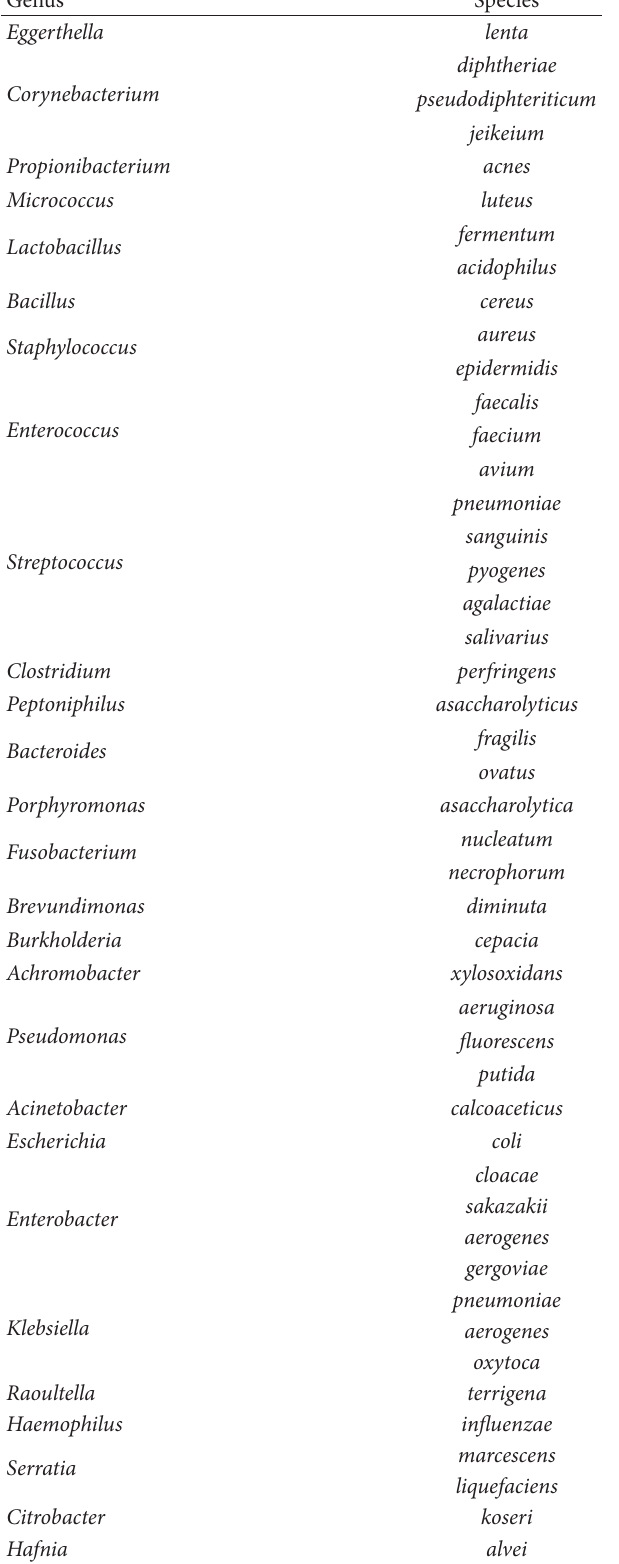
Table 1: Bacterial strains detected by the in situ hybridization method [17]. ISH test was able to detect the genomic DNA of all bacterial strains